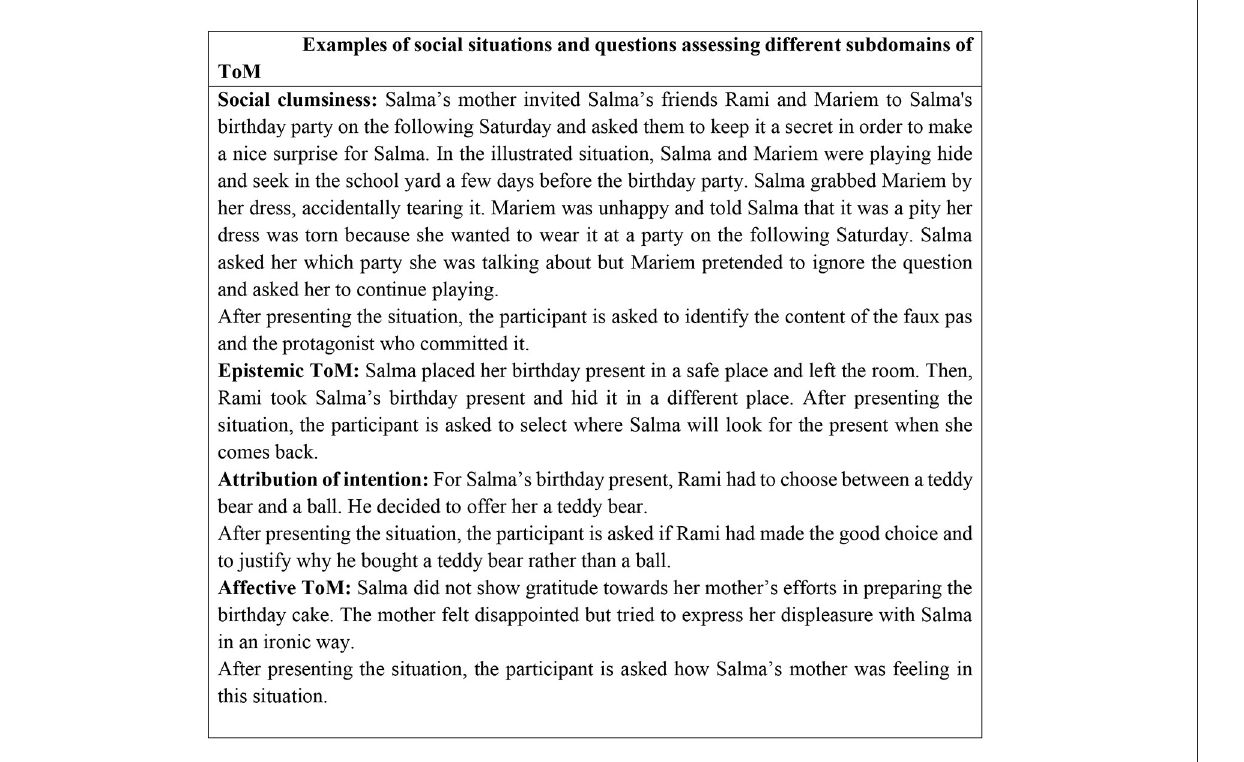
FIGURE2 Examples of social situations and questions assessing different subdomains of ToM.